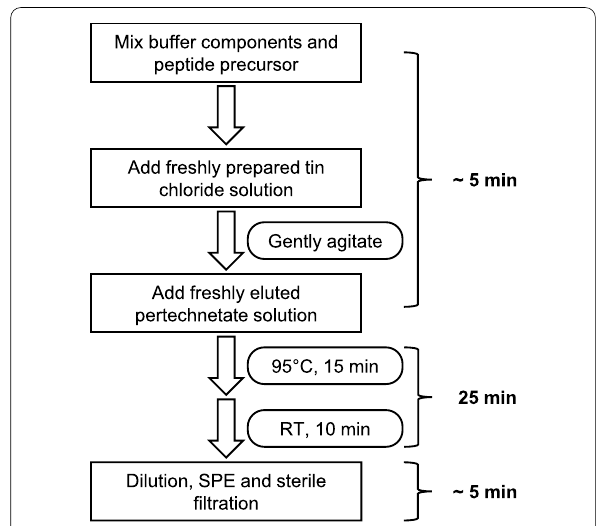
Fig. 6 Suggested work‑flow for clinical production of [ 99m